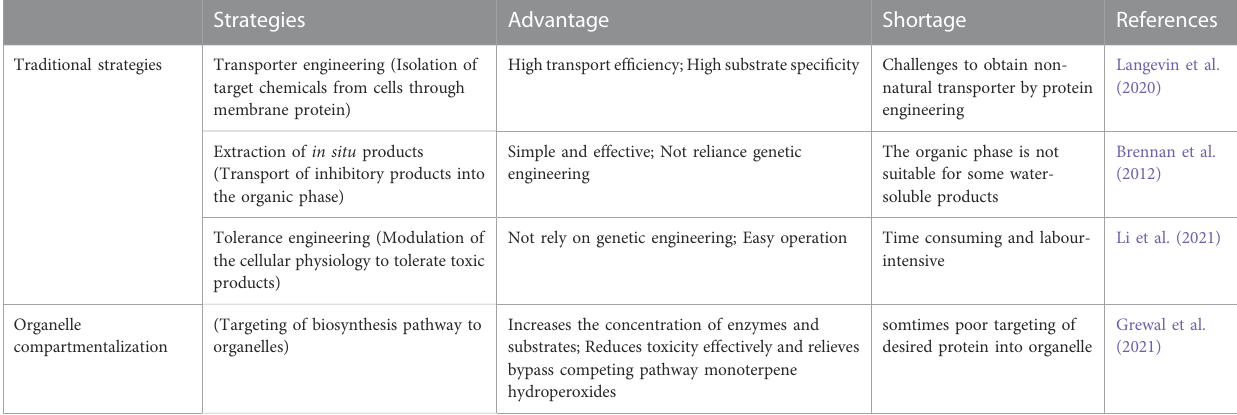
TABLE 2 Comparison of reducing cytotoxicity strategies of monoterpenoids